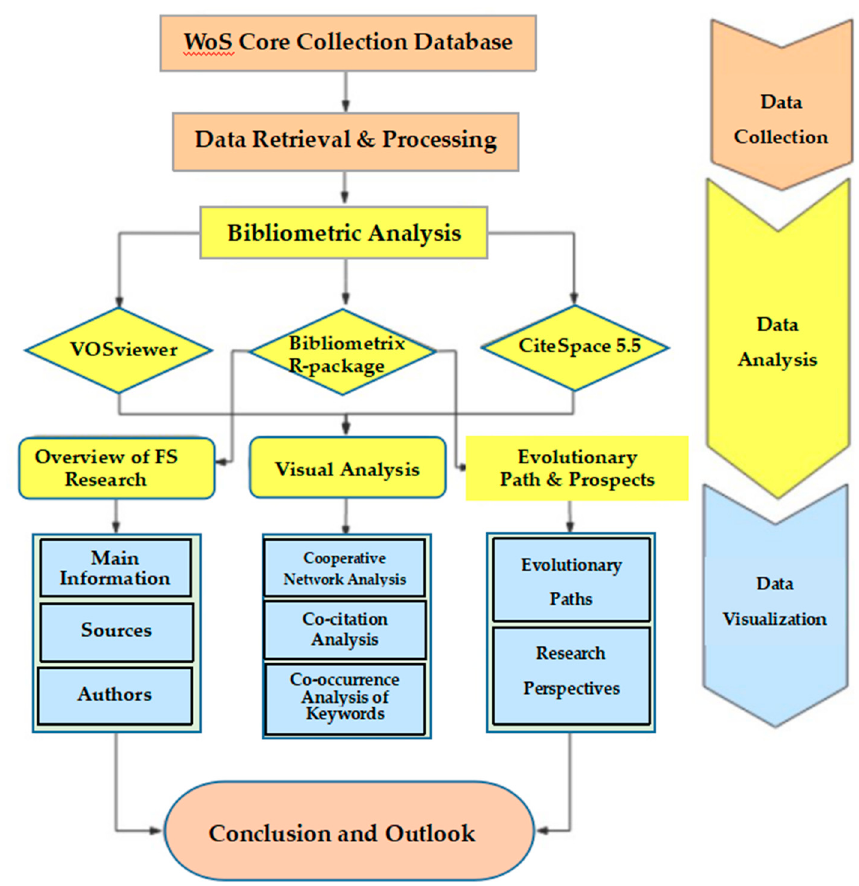
Figure 1. Bibliometrix and the recommended science-mapping workflow. FS—food security; WOS—Web of Science.